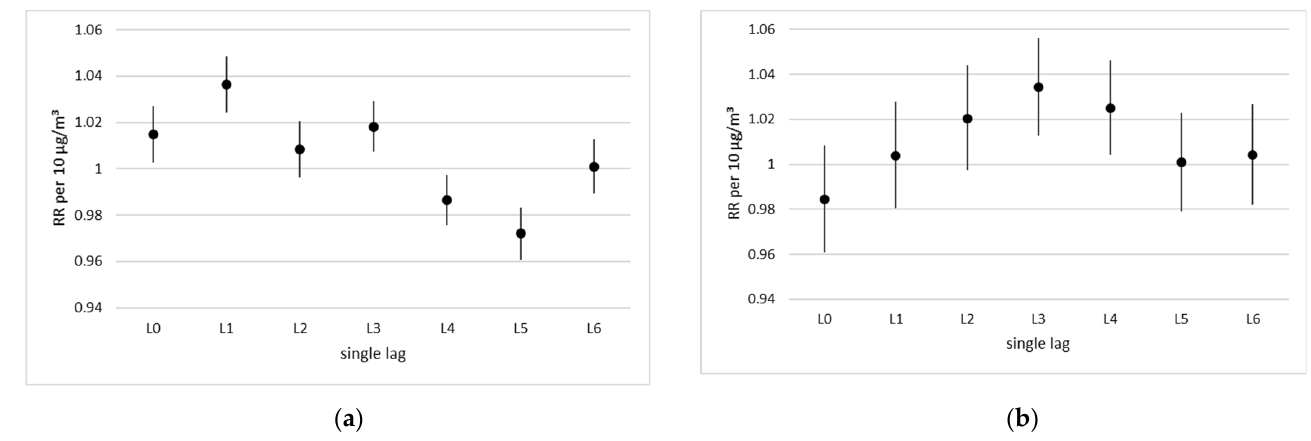
Figure A3. Sensitivity analysis: Effect (relative risk and 95% confidence interval) on stationary hospital admissions per 10 µ g/m 3 increase in PM2.5, total effect and daily effects over 10 consecutive days (lag 0–9): Optimal model (16 knots for the time smoother).